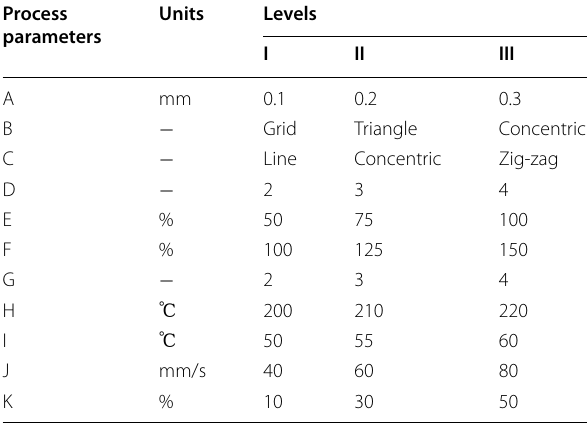
Table 1 Levels of process parameters Process parameters